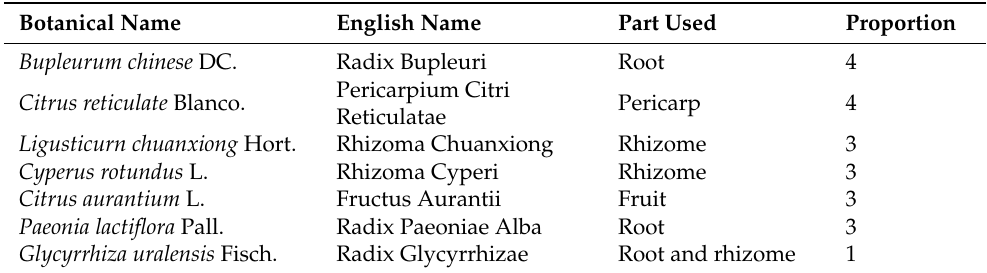
Table 1. Composition of